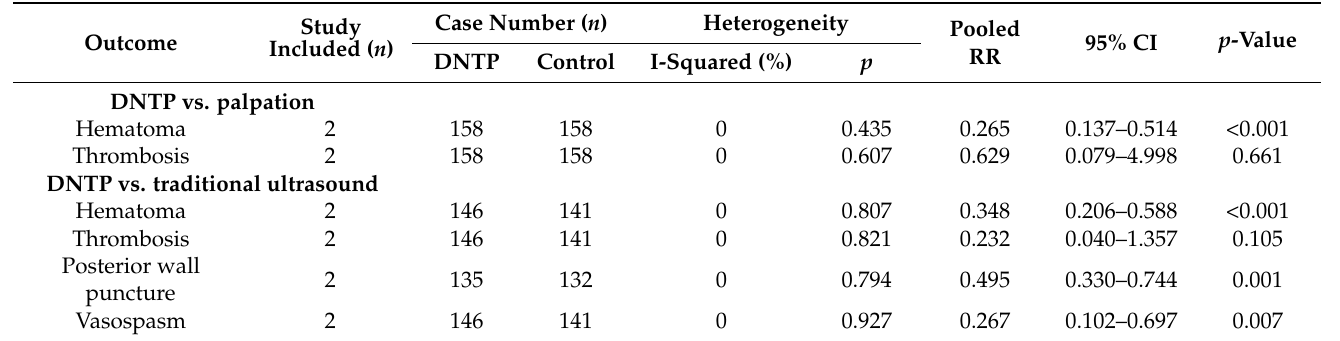
Table 4. Meta-analysis and subgroup analysis in complications of DNTP vs. palpation or traditional ultrasound method.